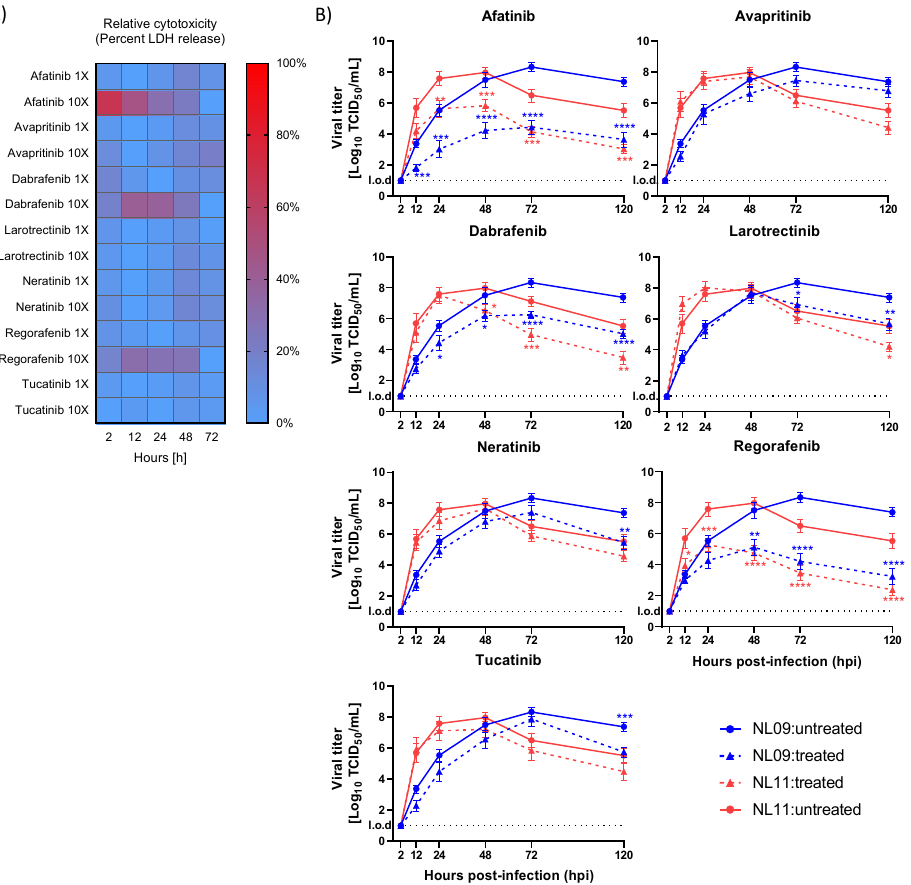
Figure 6. SMKIs impair ex vivo IAV infection. ( A ) Heatmap visualization of SMKI cytotoxicity in hPCLSs treated with [1 × ] max and [10 × ] max concentrations for up to 144hpi. At each time point, LDH release was measured using LDH-Glo Cell Viability Assay, normalized to the DMSO solvent control and calculated relative to 1% Triton-X-100-treated cells (positive control) (8 donors/ n = 24). ( B ) hPCLSs were infected with NL09 or NL11 (10 5 TCID 50 /200 uL) and incubated for 120 h with SMKIs: afatinib 5 uM (1 × ); tucatinib 1.25 uM (10 × ); neratinib 0.1 uM (10 × ); avapritinib 1.25 uM (10 × ); dabrafenib 10 uM (1 × ); regorafenib 2.5 uM (1 × ); larotrectinib 1.25 uM (10 × ). The virus was quantified by a TCID 50 / mL assay (3 donors; n = 6/virus/condition/donor from 2 independent experiments); means are ± SEM. l.o.d.: limit of detection. *, p < 0.05; **, p < 0.01; ***, p < 0.001; ****, p < 0.0001. p -values were determined by Mann–Whitney tests compared to untreated cells.